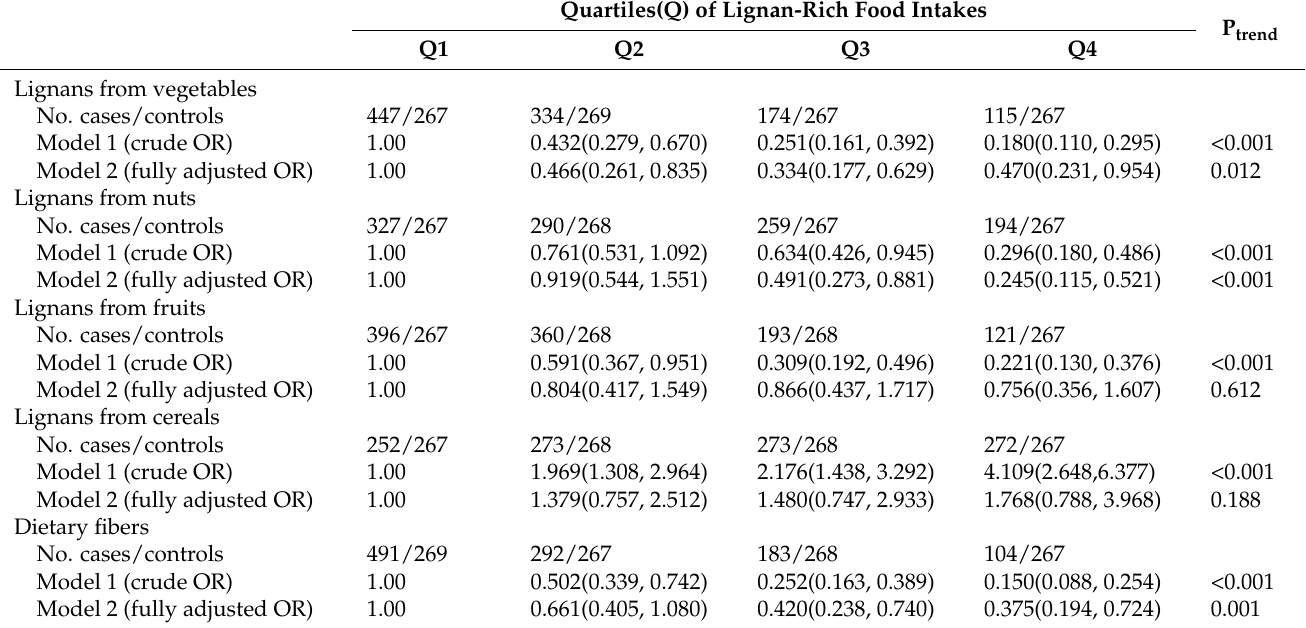
Table 4. Odds ratios (ORs) and 95% confidence intervals (95% CIs) of hip fracture risk according to quartiles of lignans from various food sources and dietary fibers in Chinese older adults. Quartiles(Q) of Lignan-Rich Food